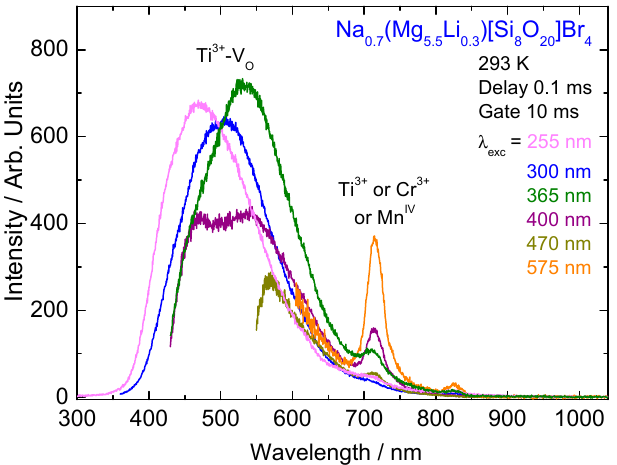
Figure A4. The emission spectra of bromohectorite recorded with several excitation wavelengths. The data are not corrected for the excitation source intensity at different wavelengths.